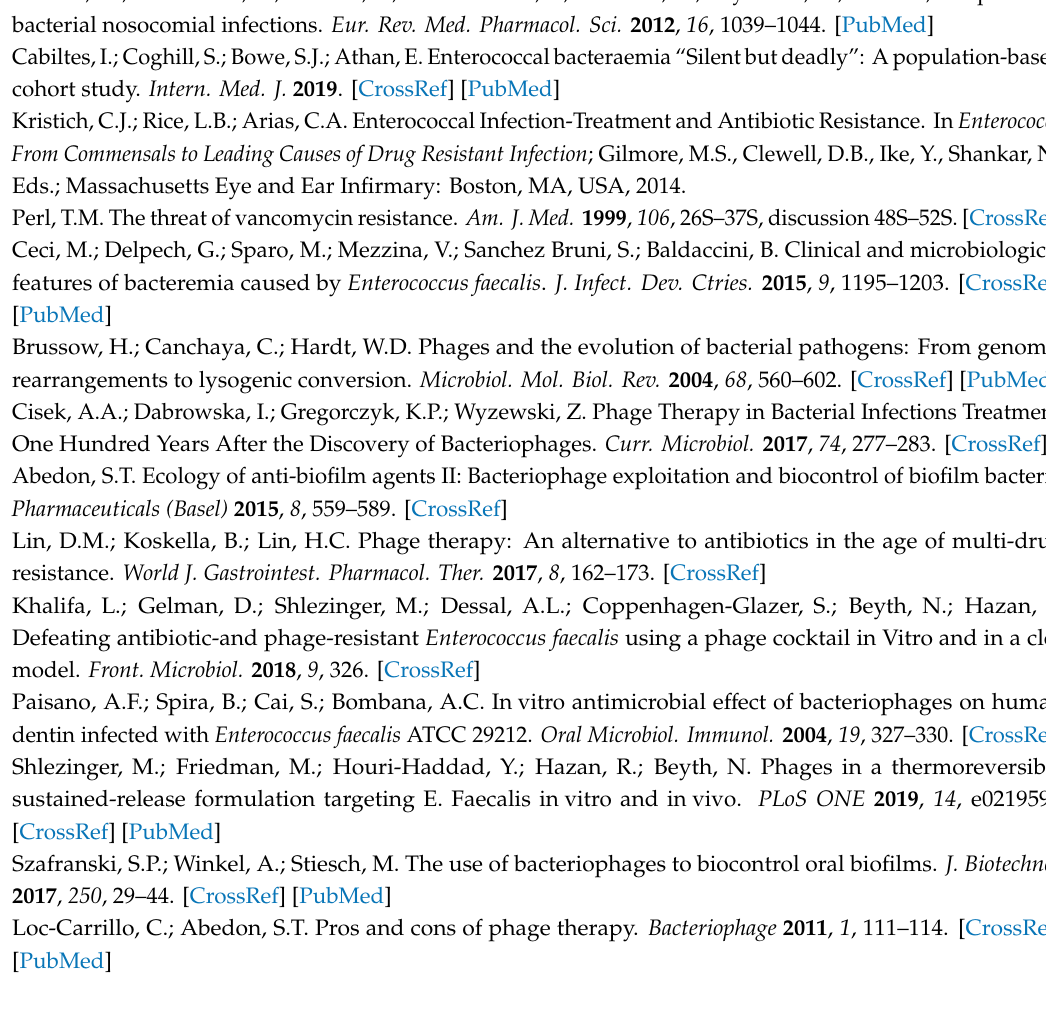
Figure S1: Scheme of the experimental setup in a 96-well microtiter plate, Figure S2: Viable counts of all the combined treatments of phage EFLK1 and vancomycin against VRE planktonic cells and Figure S3: Viable counts of all the combined treatments of phage EFLK1 and vancomycin against VRE 72 h